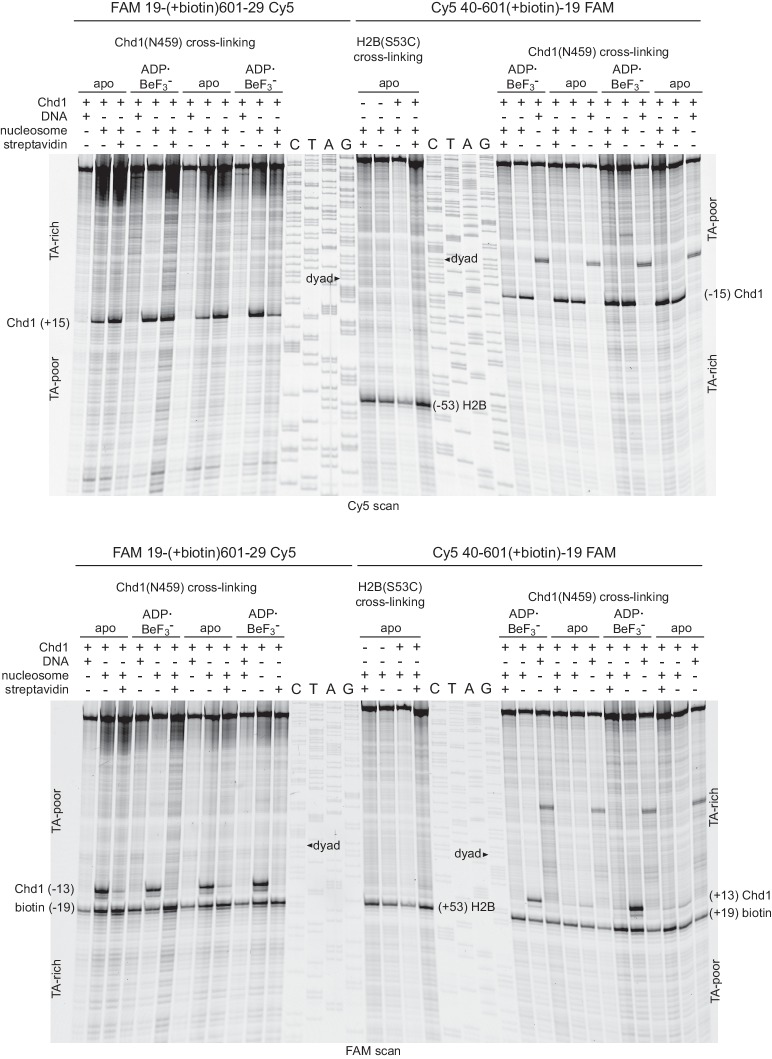
A biotin moiety on the TA-poor SHL2 interferes with Chd1 binding, independently of streptavidin.Shown are duplicate experiments for Chd1(N459C) cross-linking, using nucleosomes with a biotin on the TA-rich SHL–2 (19-[+biotin]601–29, left) or the TA-poor SHL+2 (40-601[+biotin]−19, right). For both of these nucleosomes, biotin is 19 nt from the dyad on the tracking strand, and the numbers of the construct name indicate the lengths of DNA flanking the core 601 sequence. Note that the FAM label is on the same side as the biotin, so the TA-rich and TA-poor sides appear in opposite orientations for these two nucleosomes for each scan. The Cy5 scan (top) shows that in the absence of a biotin moiety, Chd1(N459C) cross-links strongly at the TA-rich and TA-poor SHL2 sites. In contrast, the FAM scan (bottom) shows a marked decrease in Chd1(N459C) cross-linking with biotin on the TA-poor side in apo but not ADP·BeF3– conditions. The middle lanes show a replicate experiment monitoring H2B(S53C) cross-linking for the 40-601[+biotin]−19 construct, where the biotin at the TA-poor SHL2 prevents a Chd1-induced shift.